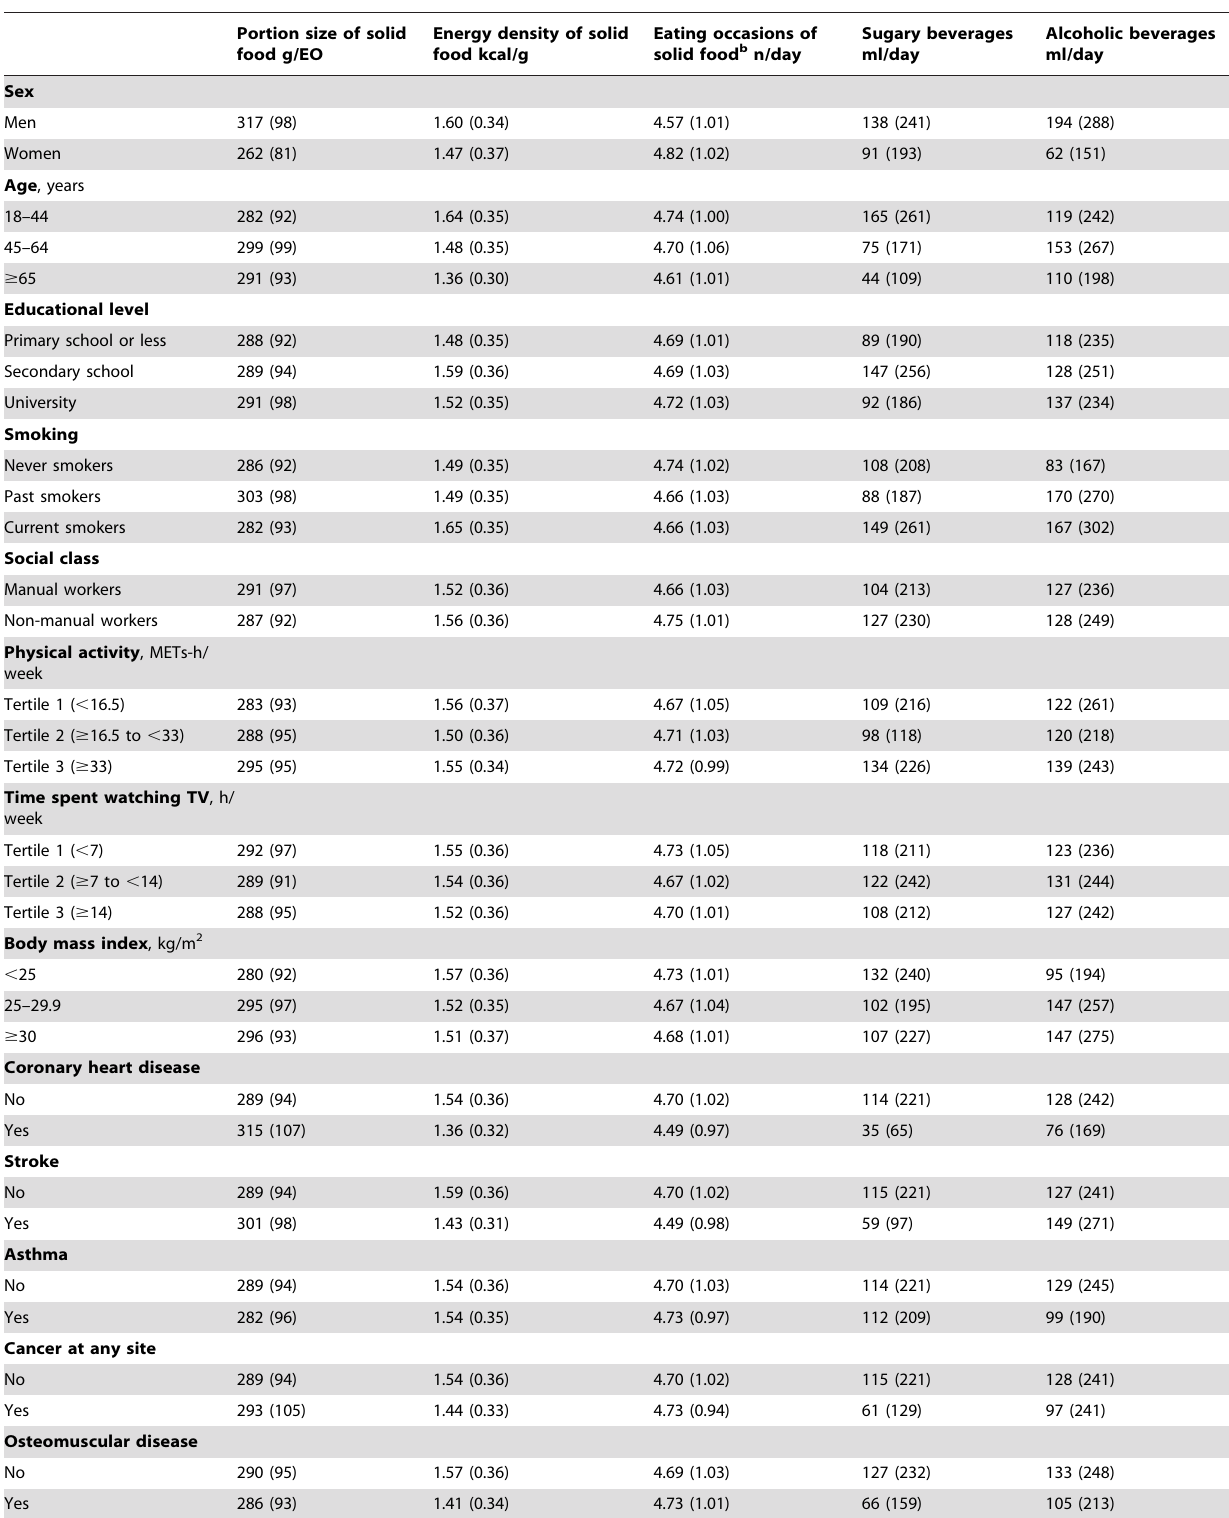
Table 2. Portion size, energy density, number of eating occasions, and consumption of sugary and alcoholic beverages, according to the characteristics of the study participants a